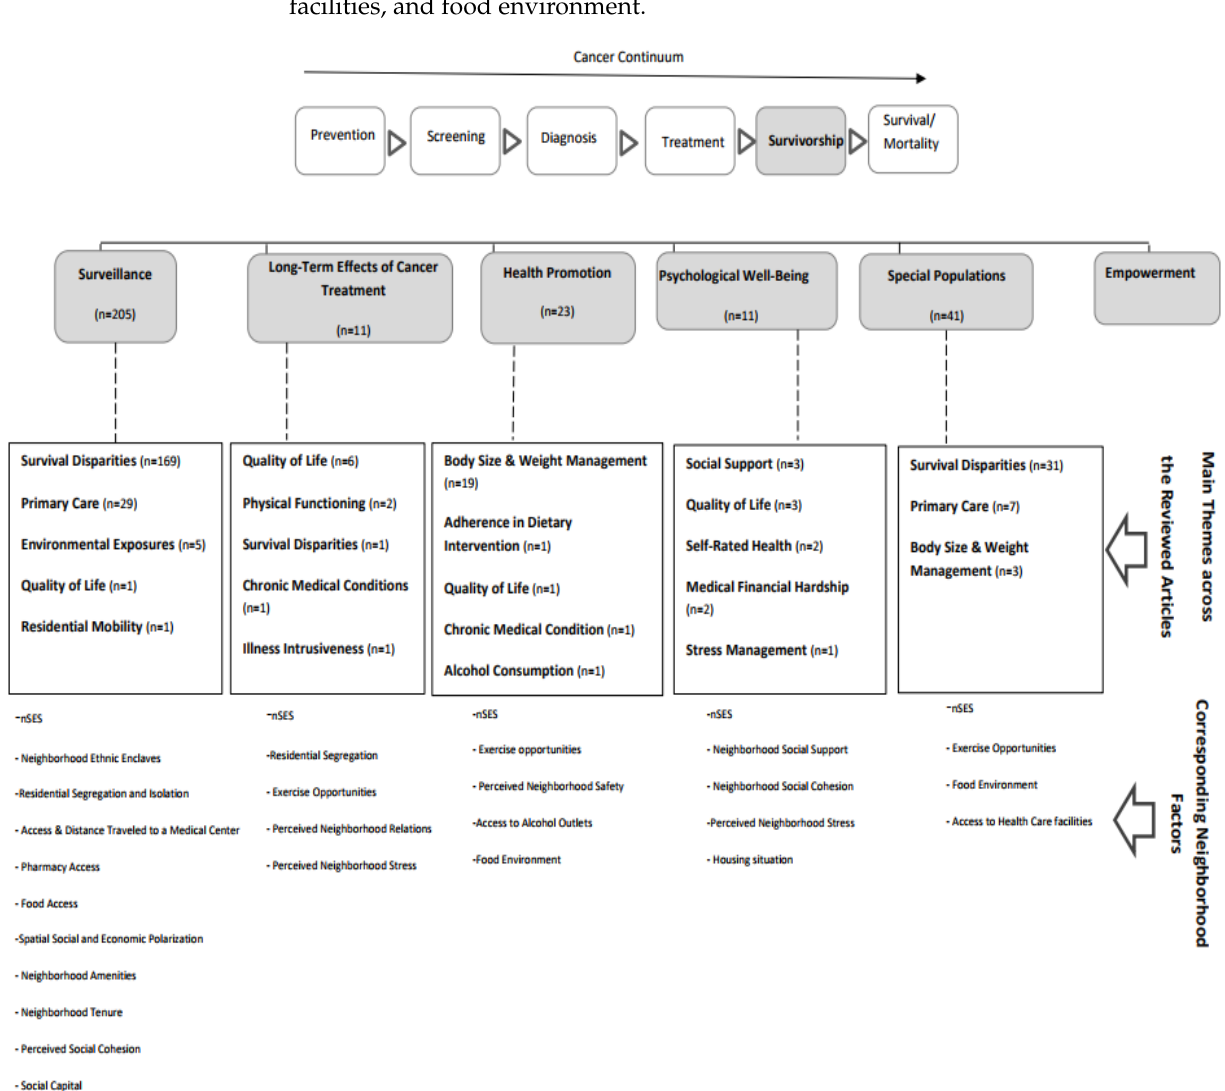
Figure 3. Main themes and the corresponding neighborhood metrics in the scoped articles.